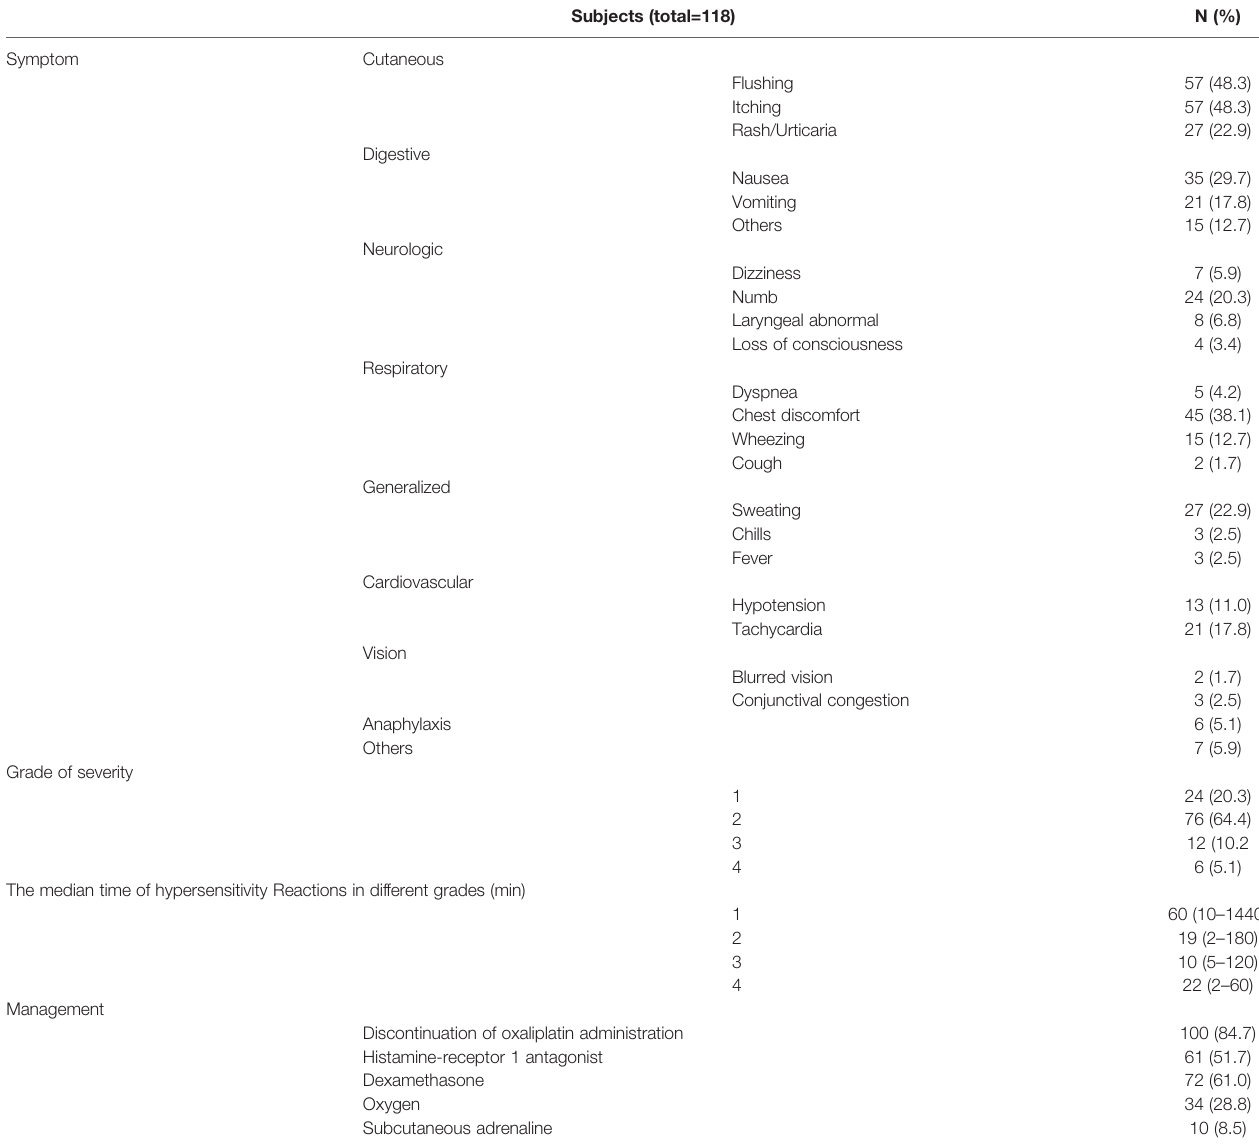
Subjects (total=118)